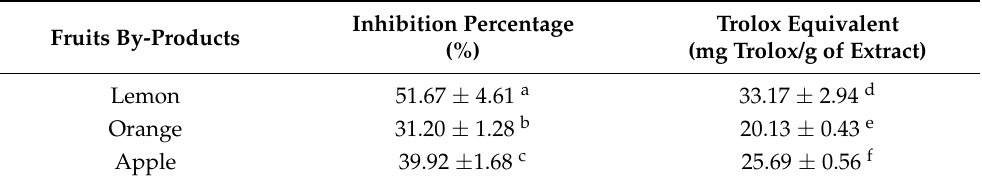
Table 1. DPPH radical scavenging capacity of different fruit by-products. The results are expressed as mean of three replicas ± SD. Different letters indicate statistical differences. Fruits By-Products